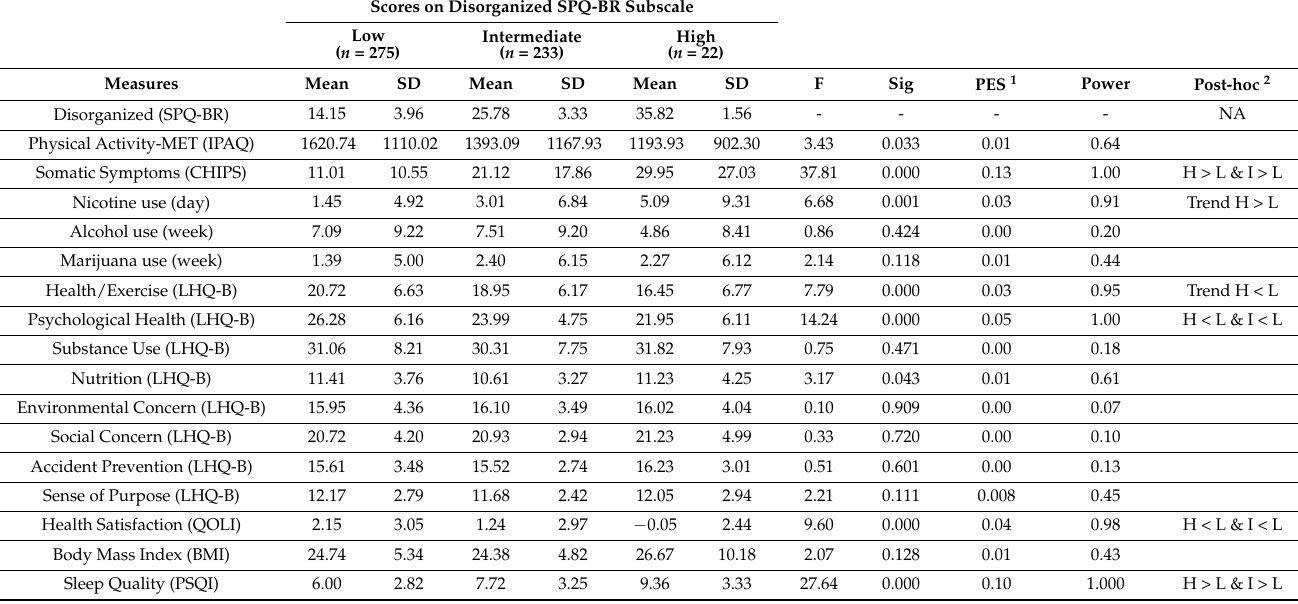
Table 4. Descriptive information for study variables and MANOVA results organized by high, intermediate, and low Disorganized schizotypy